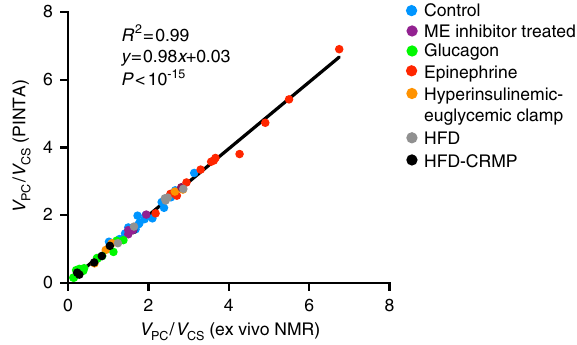
Fig. 1 V PC / V CS ratios measured by PINTA and ex vivo NMR. This ratio is identical whether measured by PINTA or ex vivo NMR analysis of rat livers